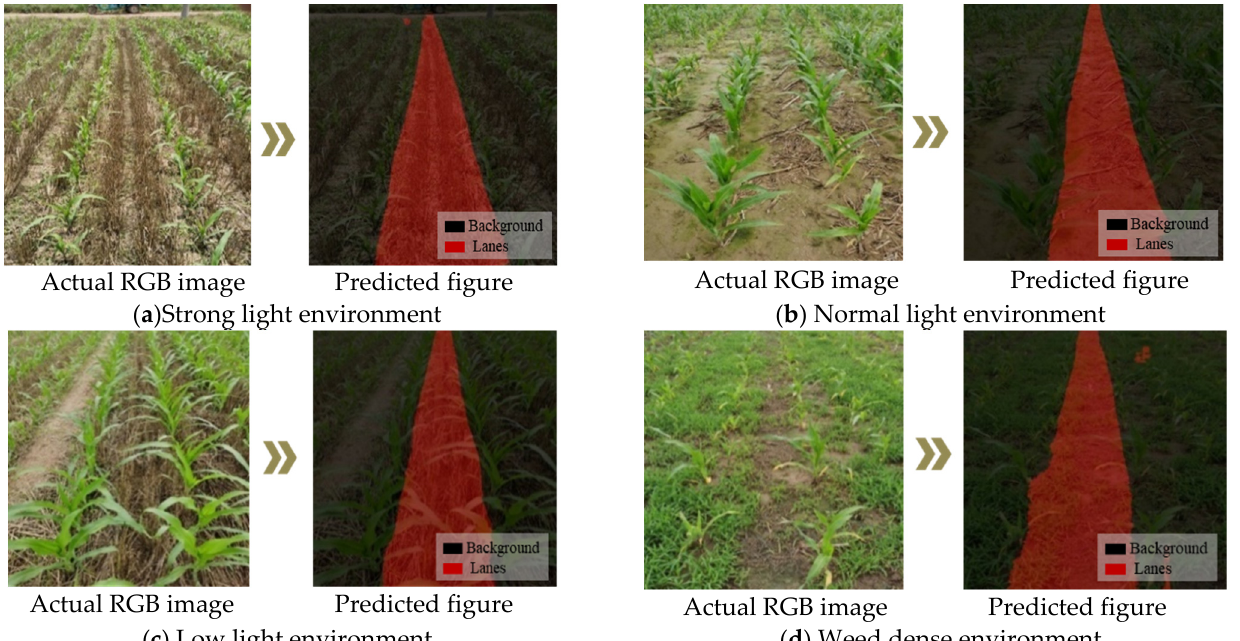
Figure 12. Prediction results of Faster-U-net network model in complex environment. ( a ) The path as predicted by agricultural robot in strong light environment. ( b ) The path as predicted by agricultural robot in normal light environment. ( c ) The path as predicted by agricultural robot in low light environment. ( d ) The path as predicted by agricultural robot in weed-dense environment.